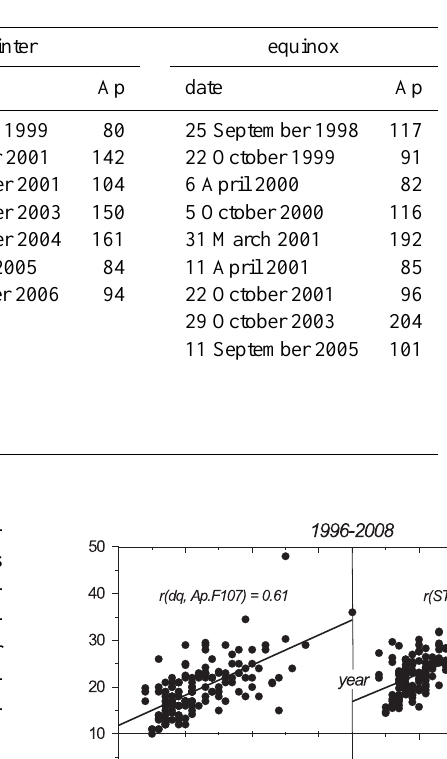
Table 1. Geomagnetic disturbances with Ap ≥ 80 during the time interval between 1996 and 2008.